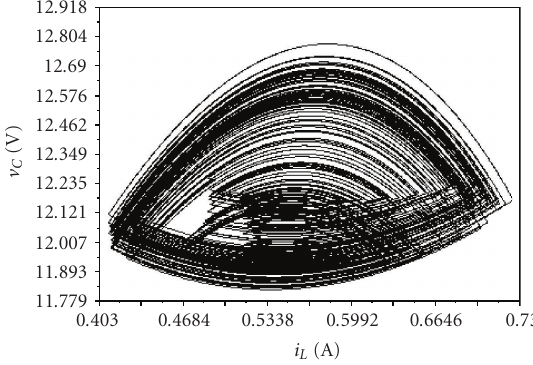
Figure 9: 4- T subharmonic operation. ( E = 41V): time waveform of the capacitor voltage.